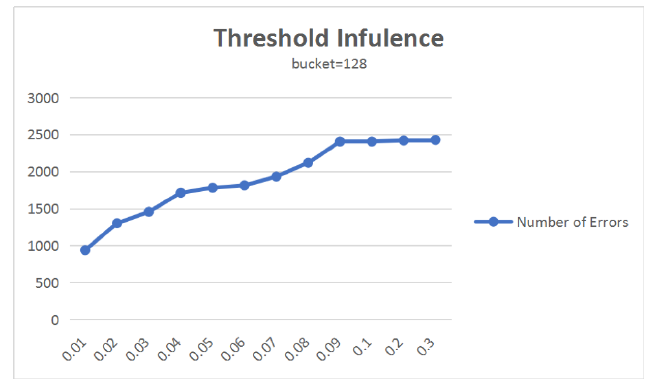
Figure 4. Threshold influence.